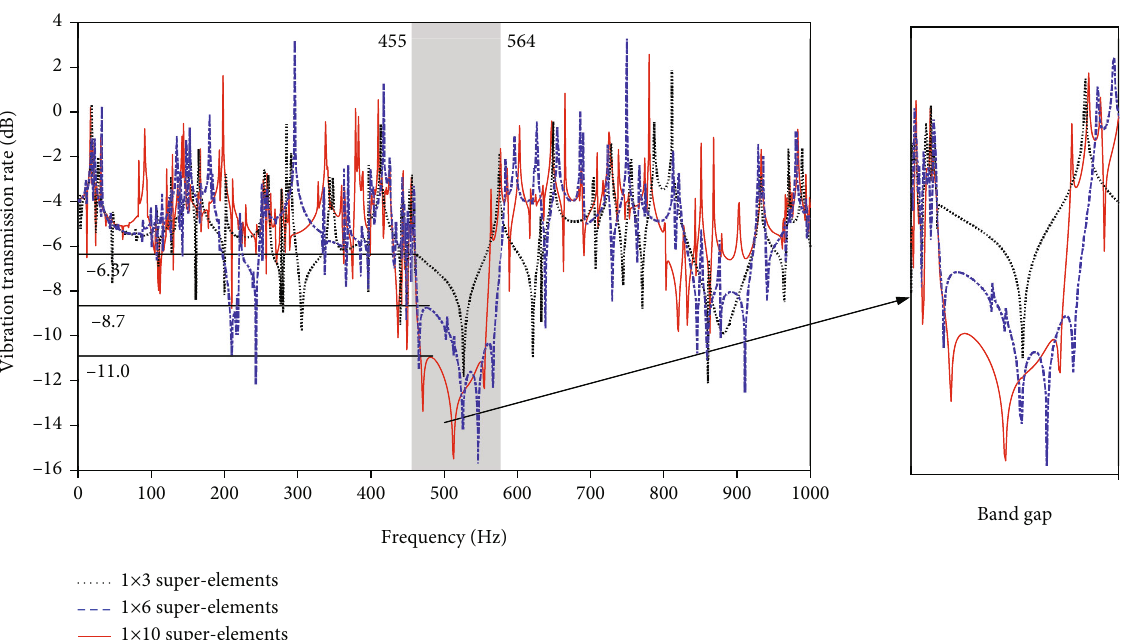
Figure 5: Vibration transmission rate of node R of the modular space